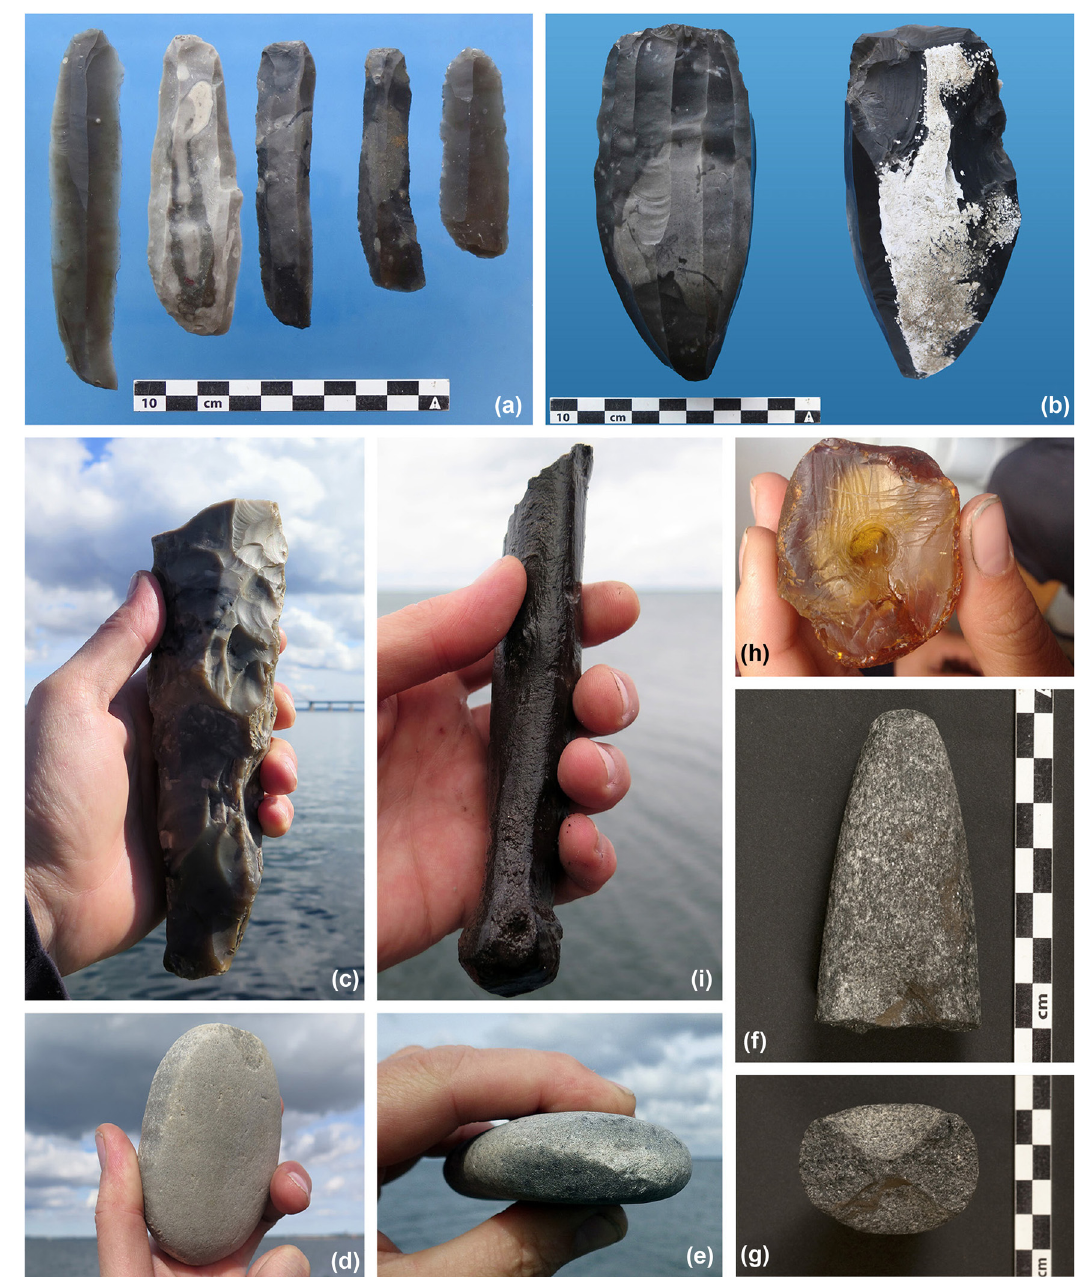
Figure 5: Artefacts from Orehoved Sejrende , ( a ) blade knives, ( b ) core axe made on blade core, ( c ) fragment of large pointed weapon, ( d – e ) faceted hammer stones, ( f – g ) butt of round - butted pecked stone axe with initiated hourglass shaped perforation ( h ) decorated piece of amber with striations and blind drill hole ( i ) fragment of wooden shaft. Photos: ( a – b ) Irina Baez - Westerberg, ( c – i ) Morten